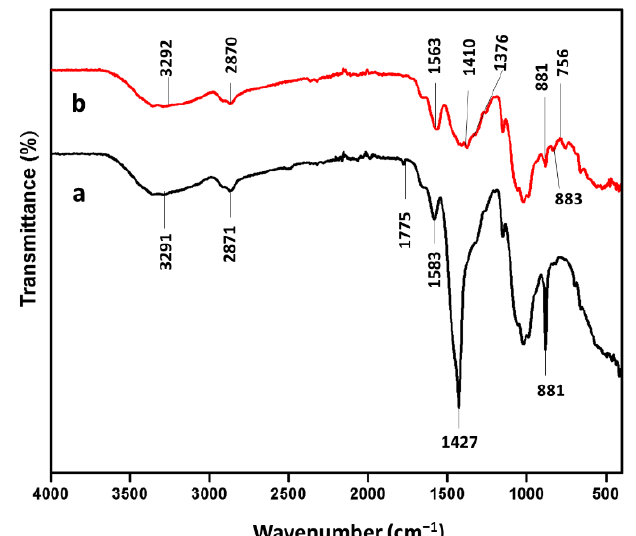
Figure 9. FTIR spectra of chitosan beads and Man/Cel5B immobilized chitosan beads. ( a ) Chitosan beads. ( b ) Immobilized chitosan beads.